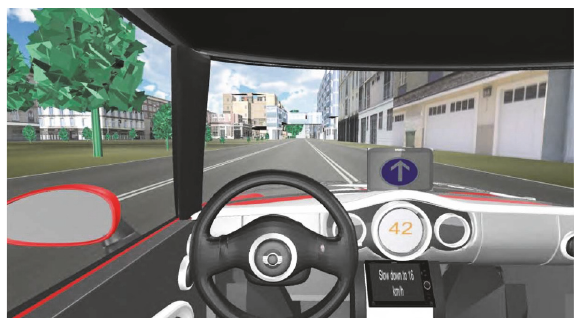
Figure 2: TLA system conveying information regarding a decrease of the current UCV velocity.